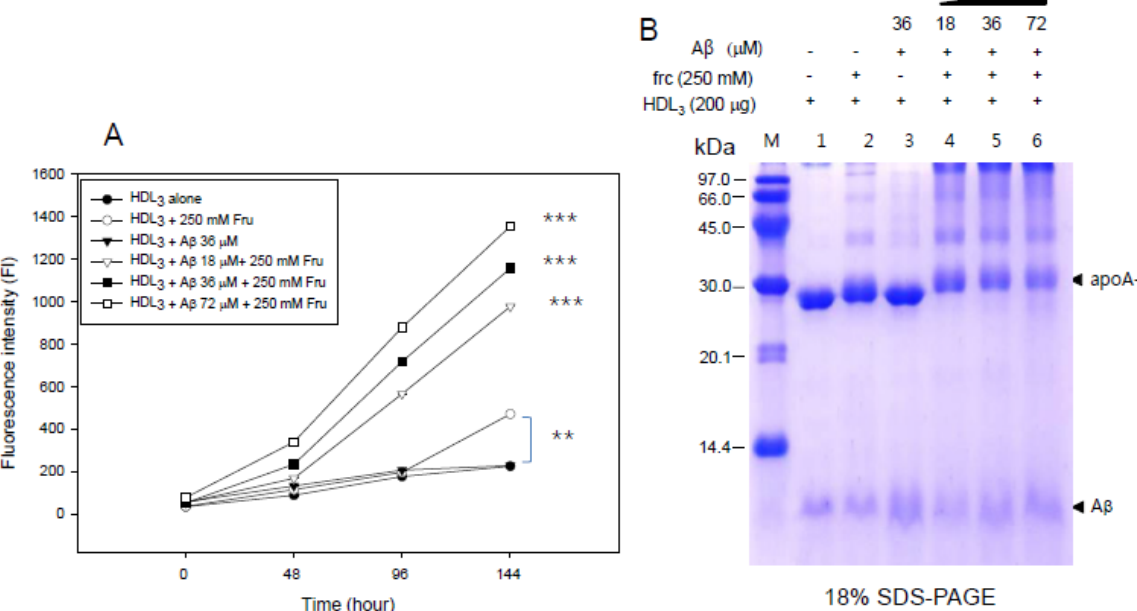
Figure 6. Synergistic increase in the extent of HDL glycation depends on the A β content in the presence of fructose. ( A ) A larger increase in fluorescence was detected in HDL with a larger increase in A β in relation to the concentration of fructose ( A ). **, p < 0.01 compared with HDL 3 alone; ***, p < 0.001 compared with HDL 3 alone. More multimerization and degradation of apoA-I were detected by Coomassie Brilliant Blue staining ( B ).